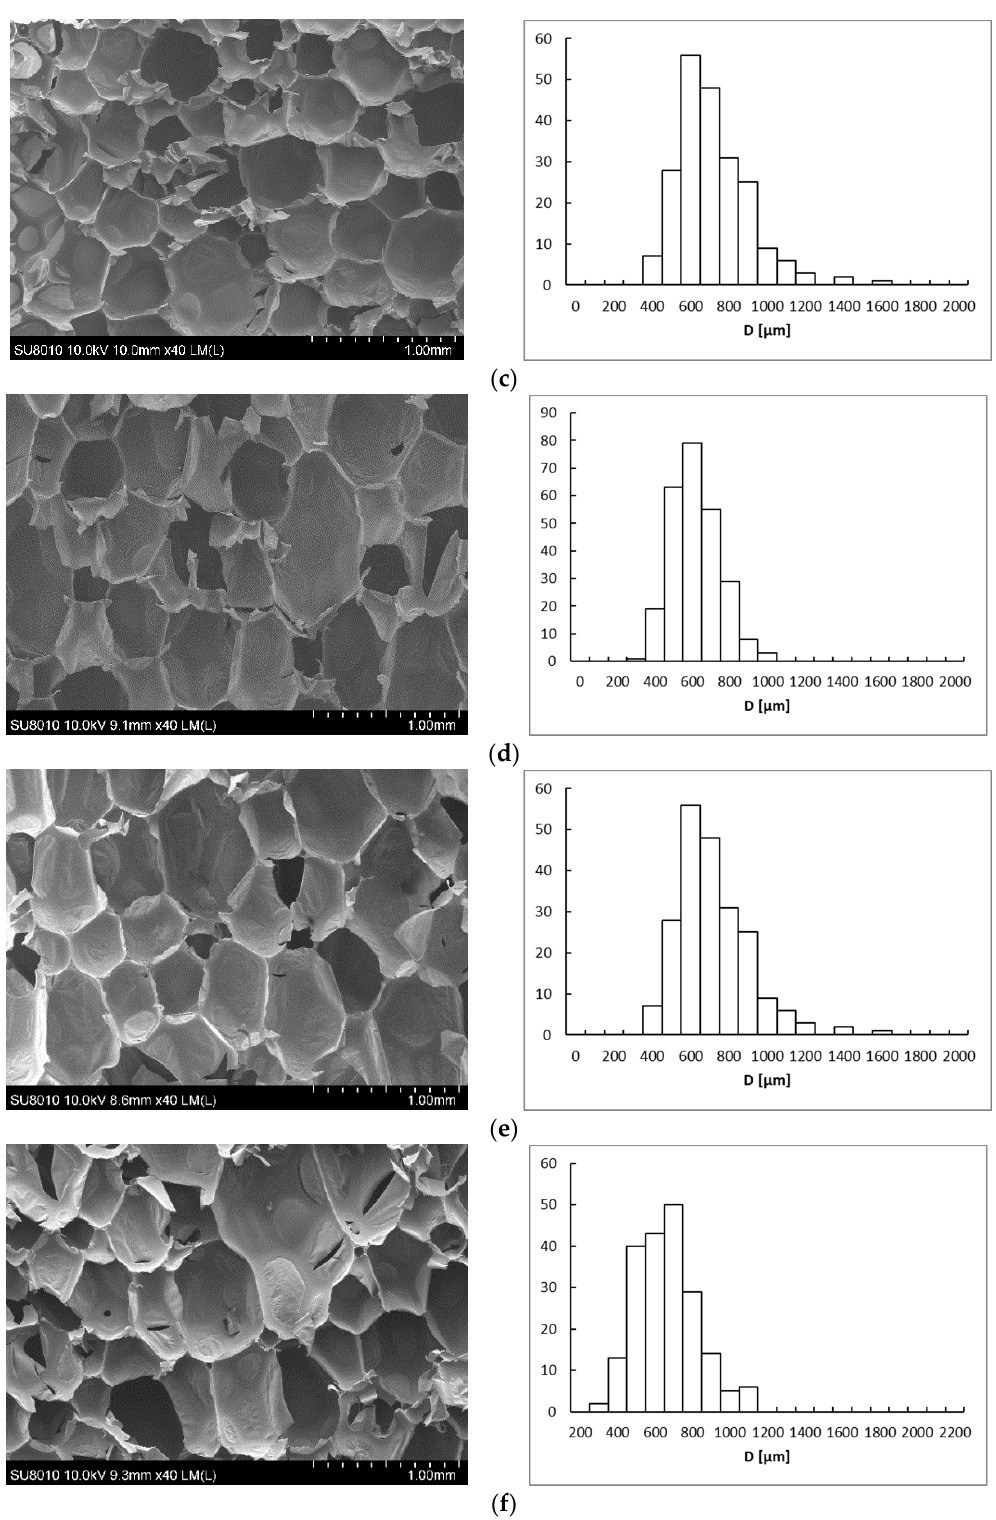
Figure 5. SEM images of breakthroughs of PU/10APP ( a ), PU/20APP ( b ), PU/30APP ( c ), PU/10HGO A ( d ), PU/20HGOA ( e ), and PU/30HGO A ( f ).